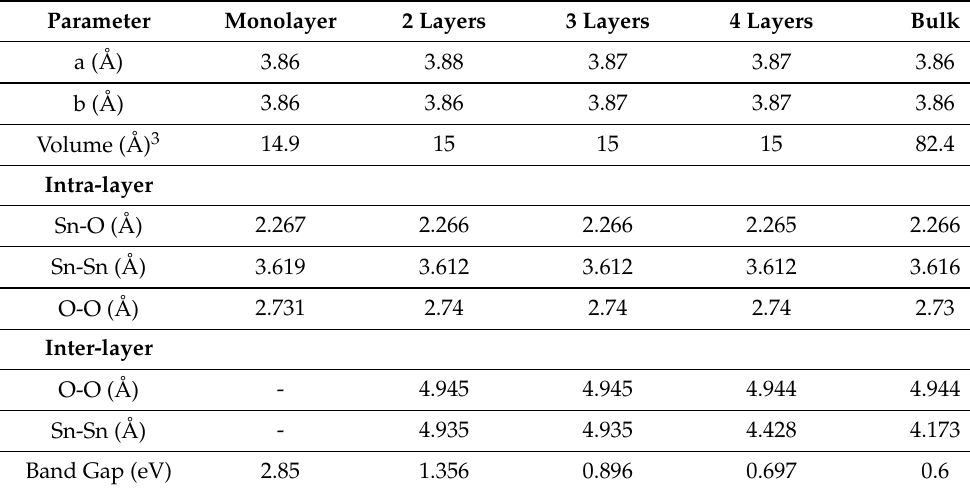
Table 3. Structural and electronic properties were calculated for bulk and layered SnO up to 4 layers. The inter-layer and intra-layer bonding parameters are